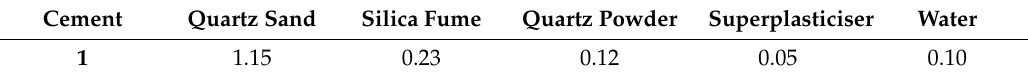
Table 2. Mix ratio.